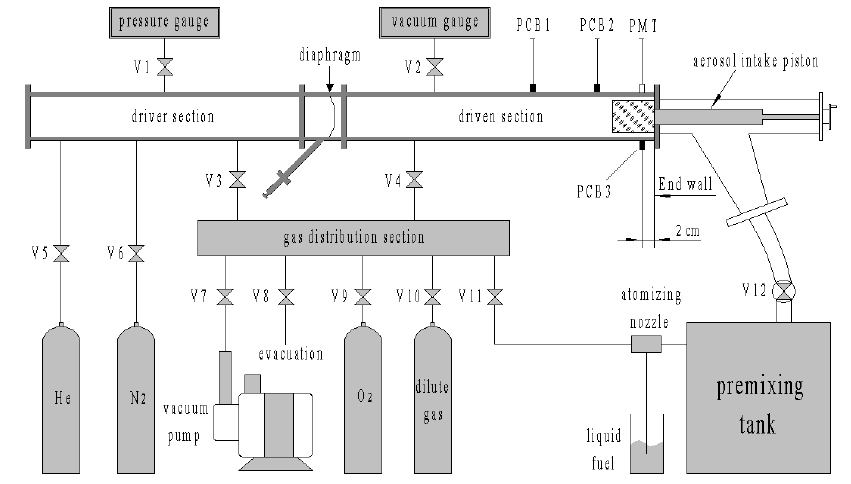
Figure 1. Sketch of the aerosol shock tube and gas distribution system.